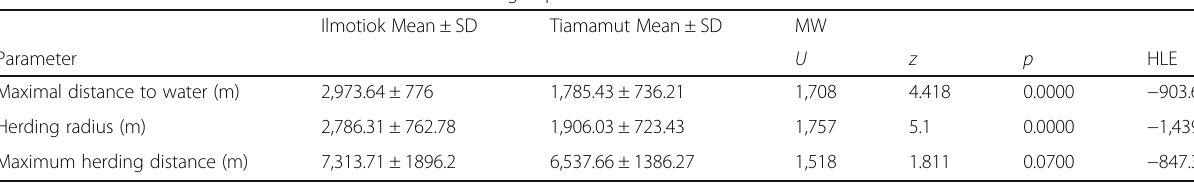
Table 4 Results of Mann-Whitney U test with Hodges-Lehmann effect (HLE) size estimator (between Ilmotiok and Tiamamut group